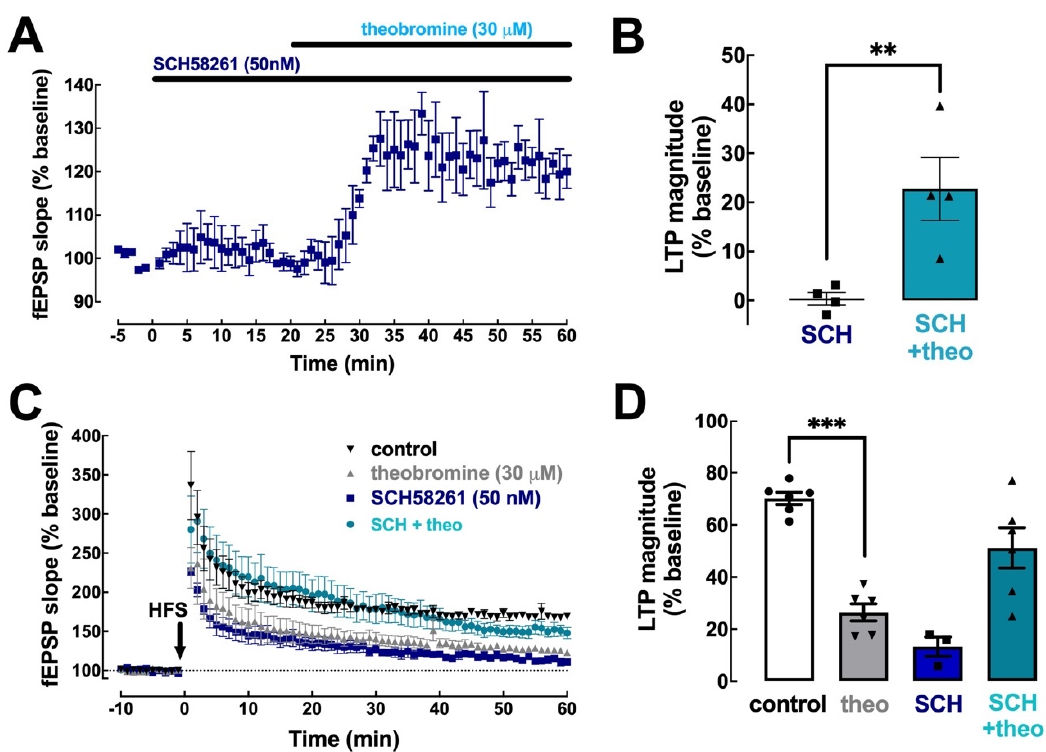
Figure 4. Blockade of A 2A R prevents the effect of theobromine on long-term potentiation. The selective A 2A R antagonist SCH58261 (SCH, 50 nM) did not modify basal synaptic transmission nor altered the effect of theobromine (theo, 30 µ M) on basal synaptic transmission in mouse hippocampal slices ( A , B ). In the presence of SCH58261 (50 nM), theobromine (30 µ M) failed to decrease LTP magnitude ( C , D ), induced with a high-frequency stimulation train (HFS: one train of 100 pulses of 1 Hz for 1 s) in Schaffer fiber-CA1 pyramid synapses of mouse hippocampal slices. Data are mean ± S.E.M. of 4 ( A , B ) and 3–6 ( C , D ) experiments. The asterisks denote significant